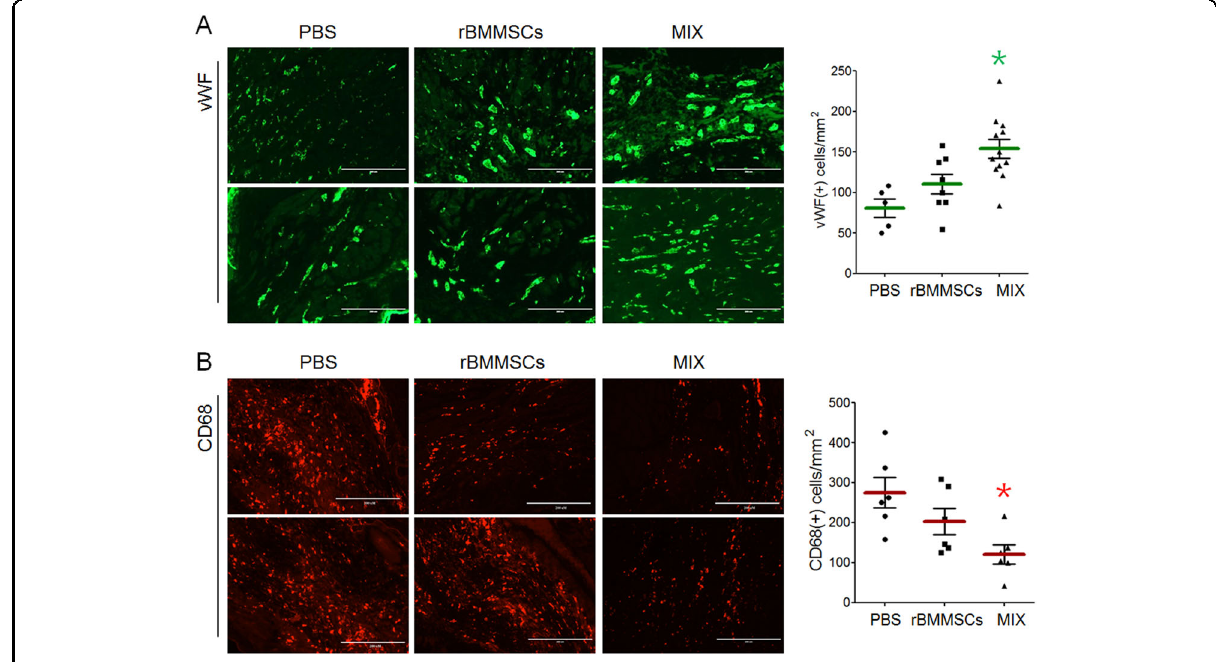
Fig. 4 Angiogenesis and macrophage in fi ltration in the infarcted myocardium. a The infarcted myocardium was immunostained for vWF to analyze angiogenesis in the PBS, rBMMSC, and MIX groups, and vWF-positive cells were counted for quanti fi cation. b Immunostaining with CD68 showed macrophage in fi ltration, and the number of CD68-positive cells was quanti fi